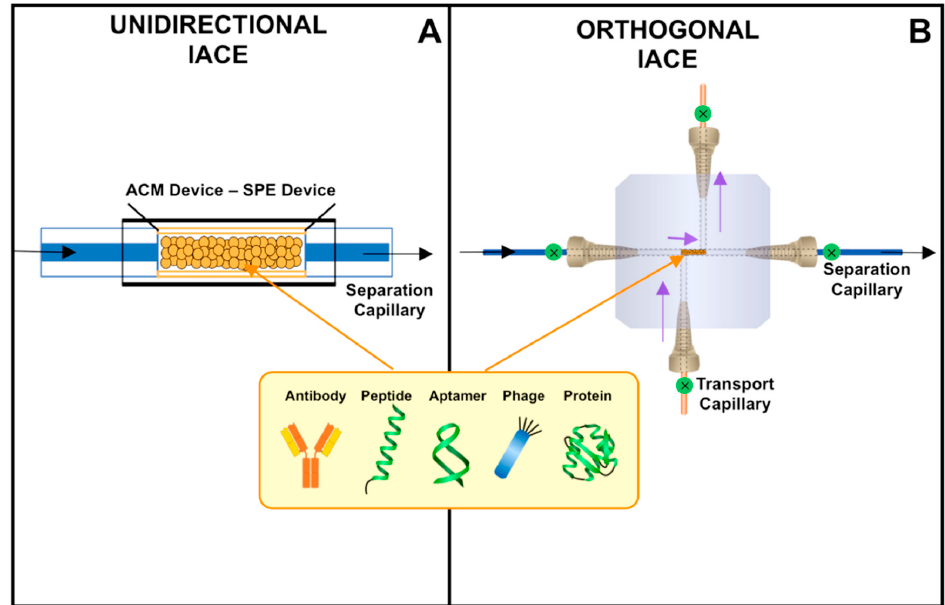
Figure 1. Schematic diagram of two designs of on-line immunoaffinity analyte concentrator- (IACE) devices. ( A ) Unidirectional IACE design; and ( B ) orthogonal IACE design. The unidirectional IACE design is operated without the presence of microvalves, whereas the orthogonal IACE design requires the presence of microvalves, as depicted in ( B ) with green circles. The orthogonal IACE device the path of fluids through the transport capillary or separation capillary. Black arrows indicate flow direction of bu ff ers in the separation capillary, and migration direction of the separated analytes